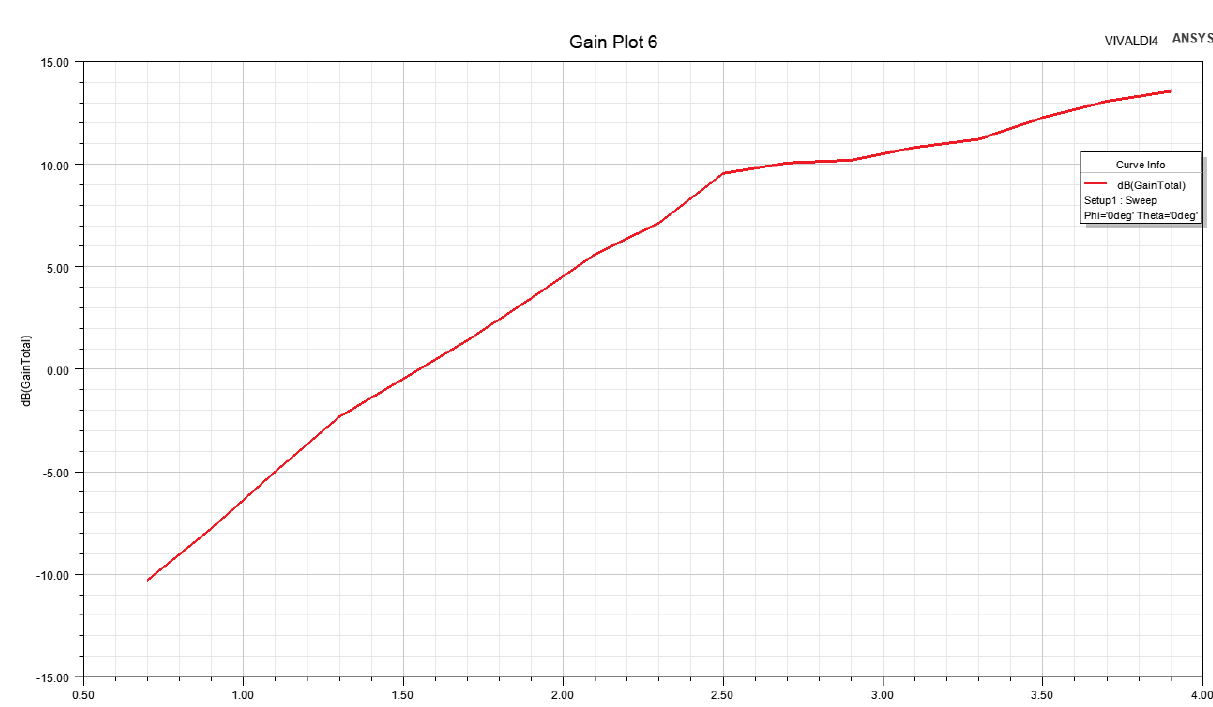
Figure 9. Radiation efficiency.